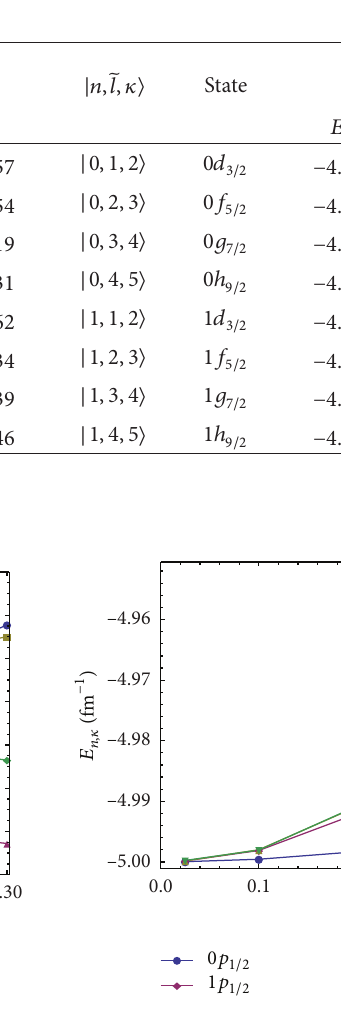
Figure 4: The variation of the energy spectrum 𝐸 𝑛,𝑘 for tensor Hulth´en potential in the case of spin symmetry according to the screening parameter 𝛿 . Here we selected 𝑈 0𝐻 = 0.1 , 𝛼 = 0.01